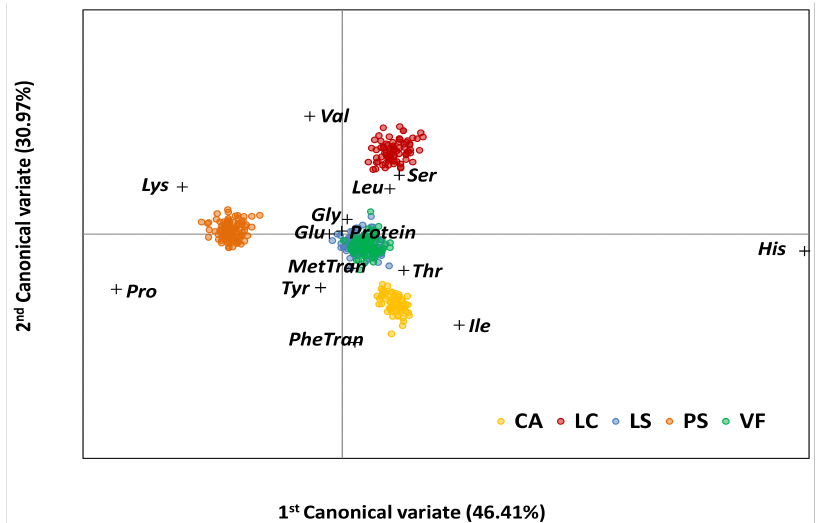
Figure 4. Canonical variate analysis biplot based on 17 traits related to protein quantity and quality in five grain legume species. Legend: in yellow, Cicer arietinum (CA), n = 86; in red, Lens culinaris (LC), n = 92; in blue, Lathyrus sativus and their crop wild relatives (LS), n = 109; in orange, Pisum sativum and their crop wild relatives (PS), n = 118; and in green, Vicia faba (VF), n = 92. The variance explained by each canonical variate axis is given in the axis